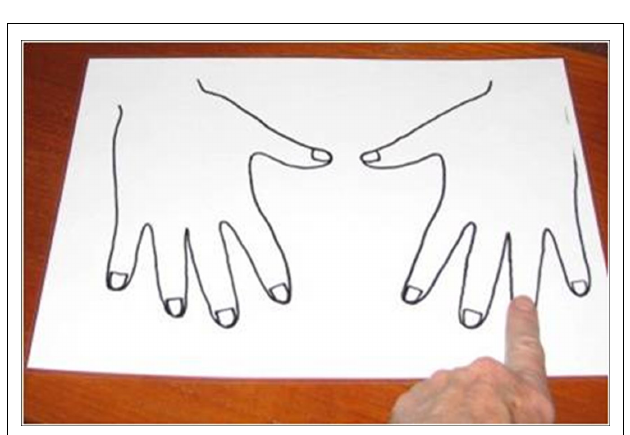
FIGURE 2 | Investigator pointing to finger on